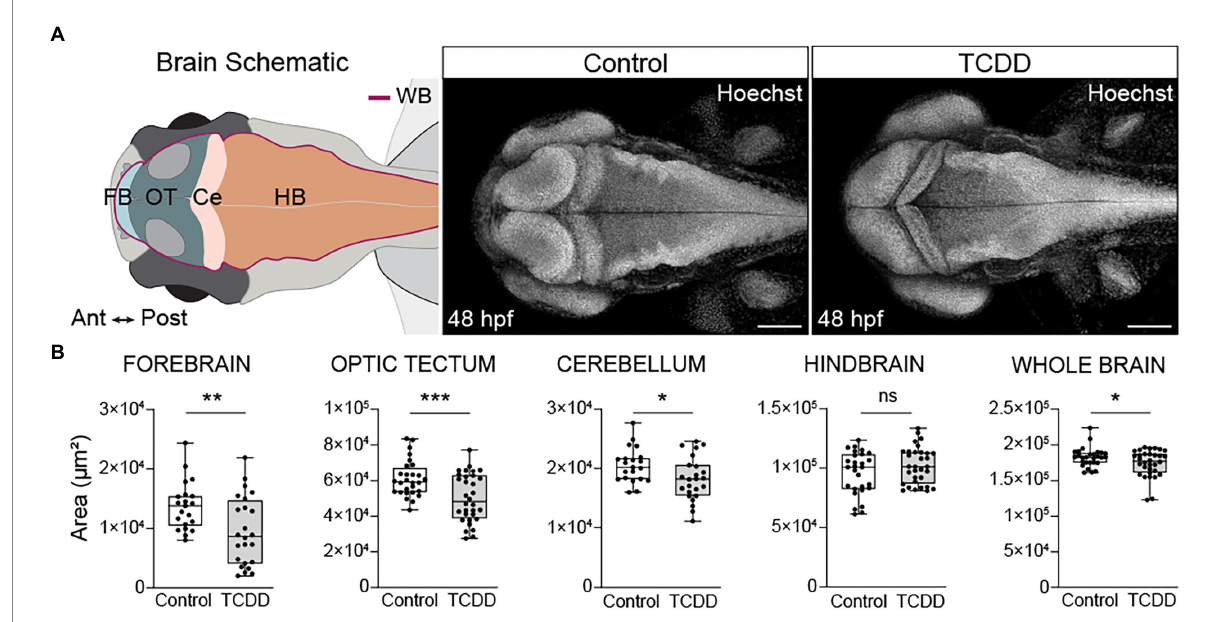
FIGURE 1 Developmental TCDD exposure impairs embryonic brain morphogenesis. (A) Schematic of the embryonic zebrafish brain at 48 hpf depicting the brain regions quantified in B. Dorsal confocal images of Hoechst (DNA, white) stained embryos and larvae were used to visualize and quantify differences in gross brain morphology. Embryos were exposed at 4 hpf to either control (DMSO) or TCDD (10 ppb) for 1 h. (B) Regional and whole brain size was determined by measuring the area of the forebrain (FB), optic tectum (OT), cerebellum (Ce), hindbrain (HB), and whole brain (WB) in control and TCDD-exposed embryos. Statistical significance determined by Welch’s t-test, * p < 0.05, ** p < 0.01, *** p < 0.001. n = 21–26 fish/group across 3 replicates. Anterior (Ant) is left, posterior (Post) is right in all confocal micrographs. Scale bar = 100 μ m, magnification =